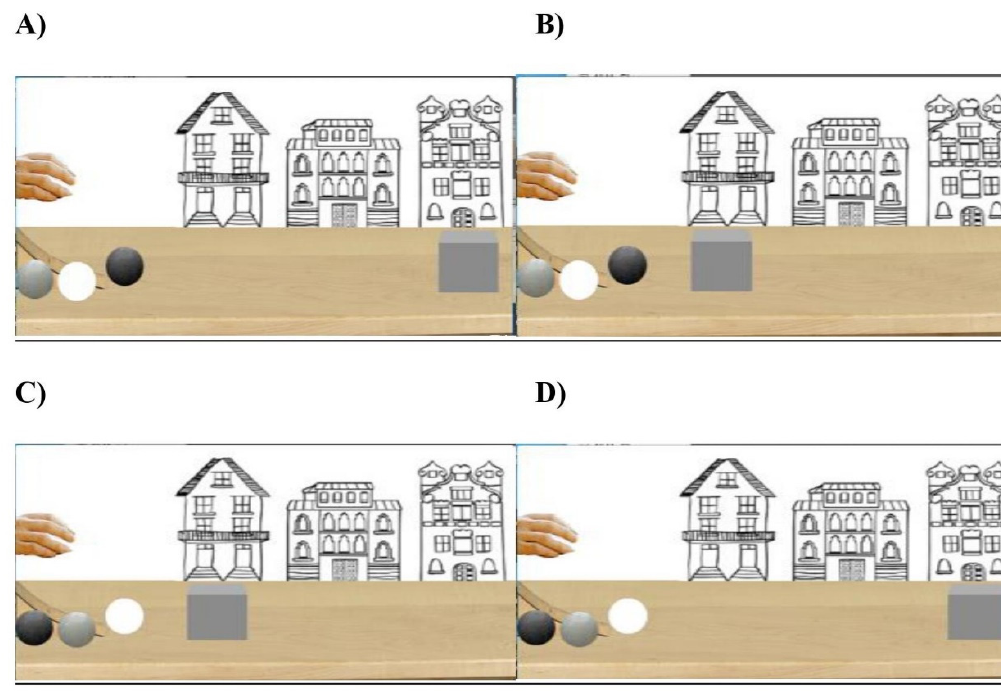
Figure 1. From top to bottom: Top: ( A ) Dark ball likely, ( B ) Dark ball unlikely, Bottom: ( C ) Bright ball likely, ( D ) Bright ball unlikely outcomes.